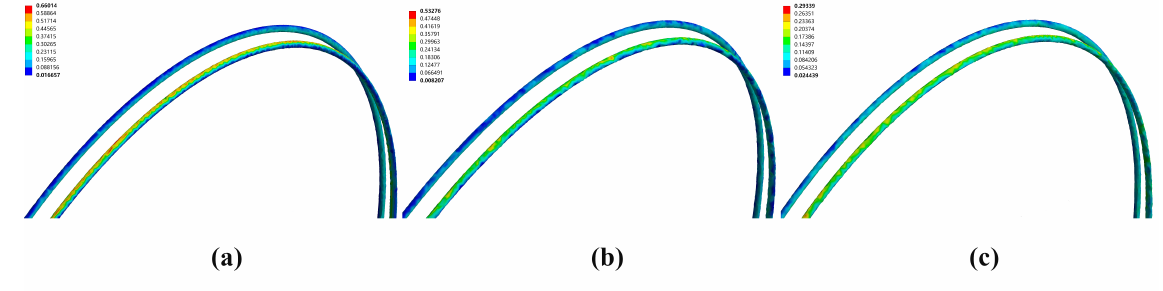
Figure 6. FEA of the O-ring: ( a ) FEA with poor condition parameters and tightening sequences; ( b ) FEA with relatively ideal condition parameters and poor tightening sequences; ( c ) FEA with ideal condition parameters and tightening sequences.